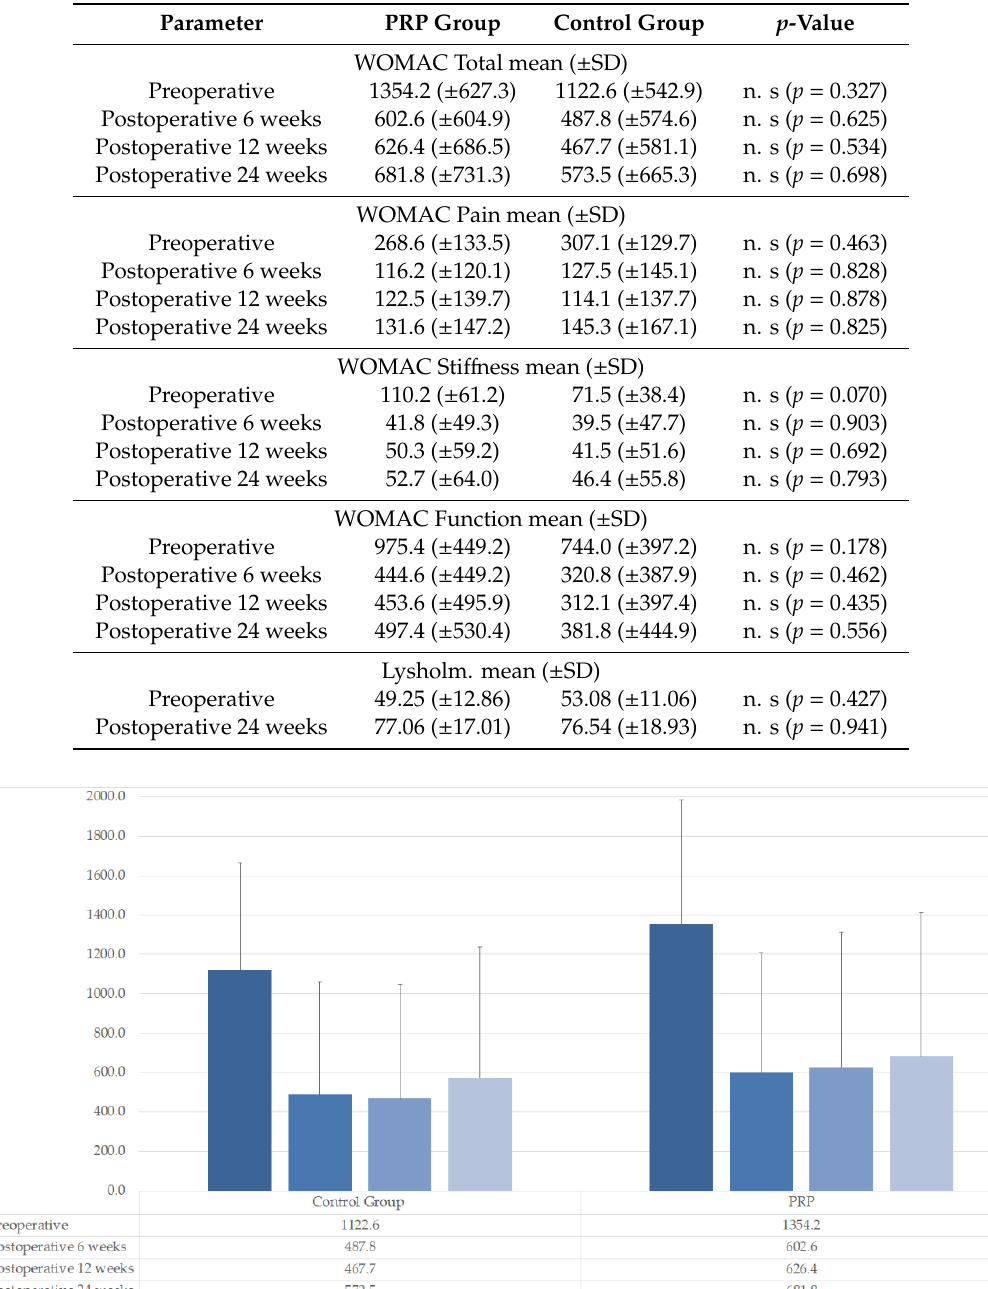
Table 4. Comparison of results in PRP and the control group.